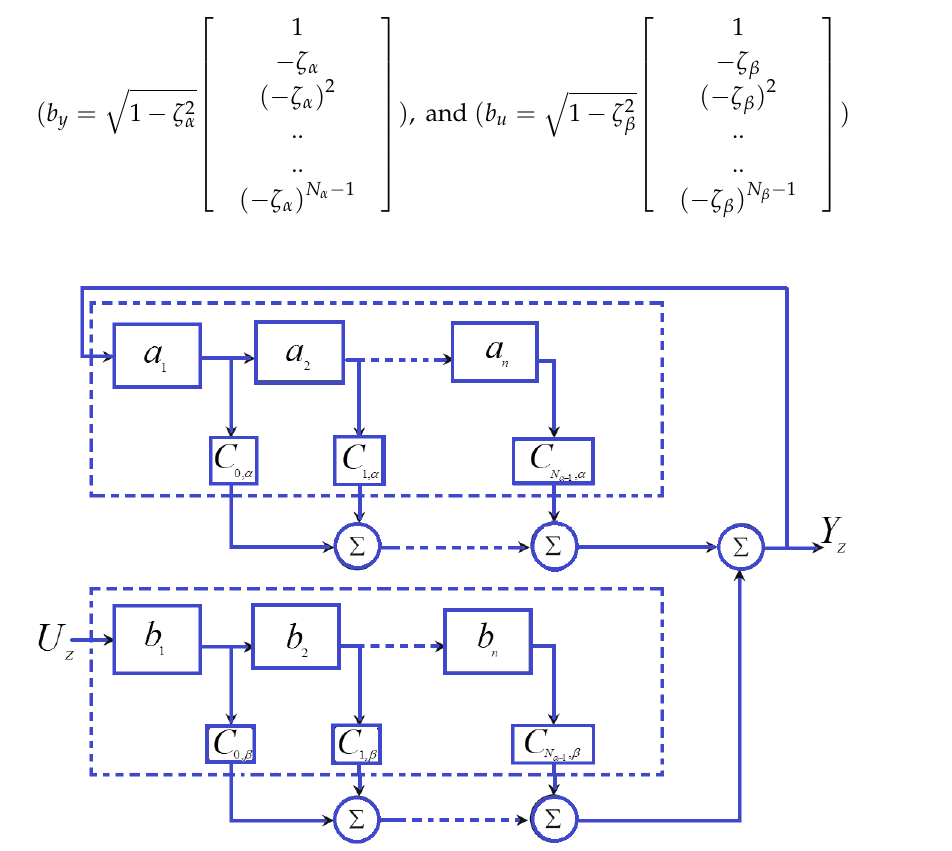
Figure 6. ARX-Laguerre Orthonormal Filter Technique.